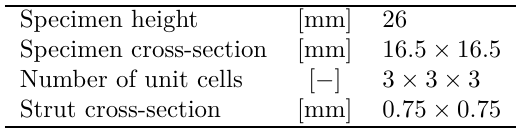
Table 1. Design parameters - common